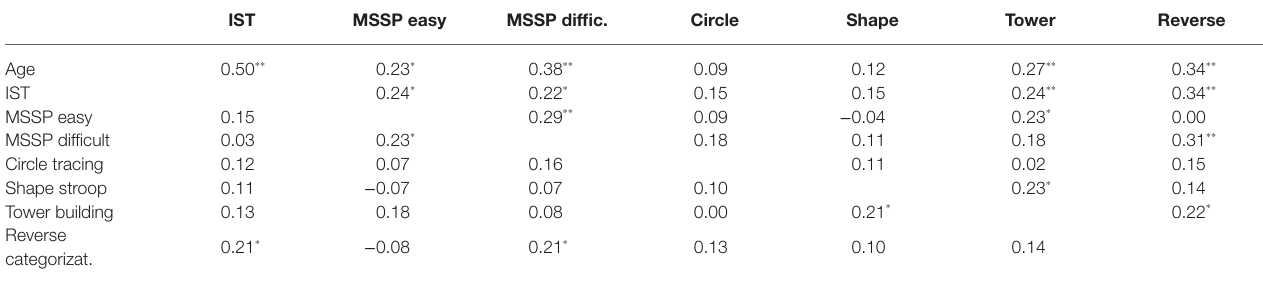
TABLE 2 | Pearson correlations and partial correlations between working memory, inhibition, and shifting